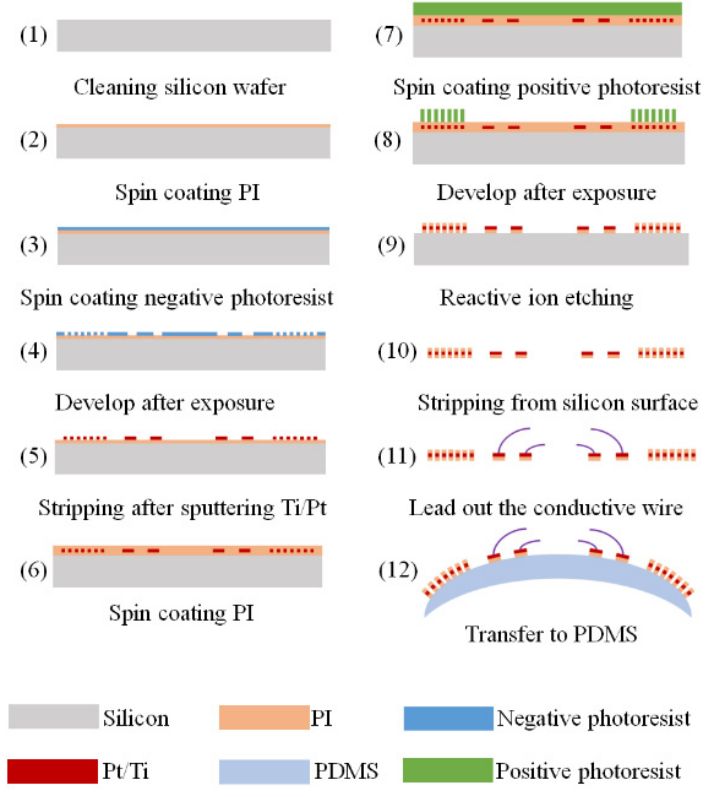
Figure 2. Process flow of sensor fabrication.